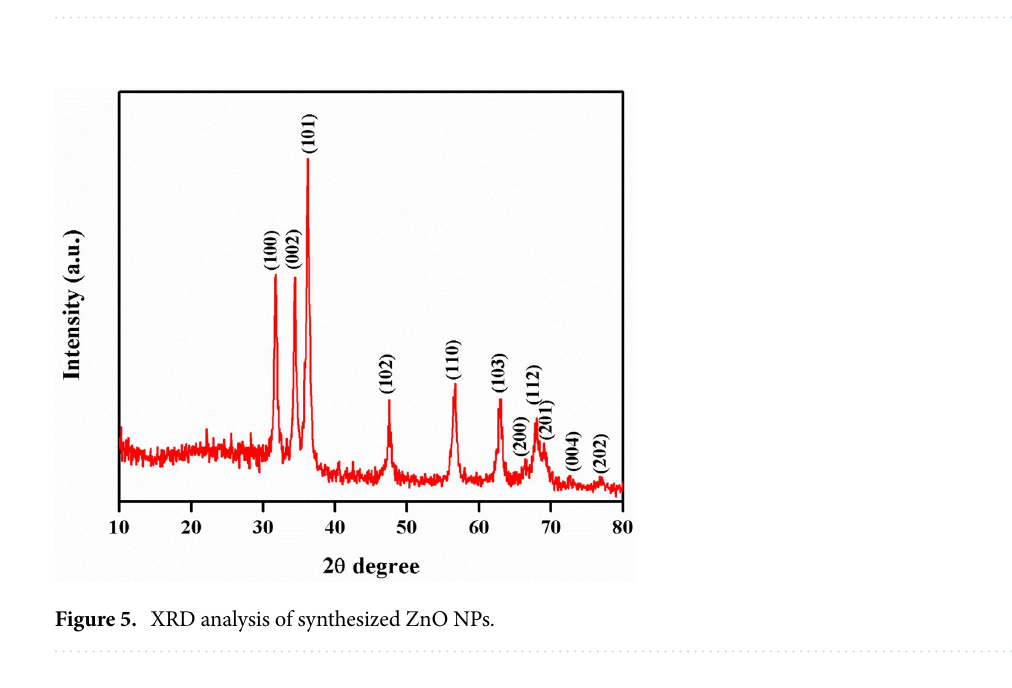
Figure 4. EDX analysis of synthesized ZnO NPs.